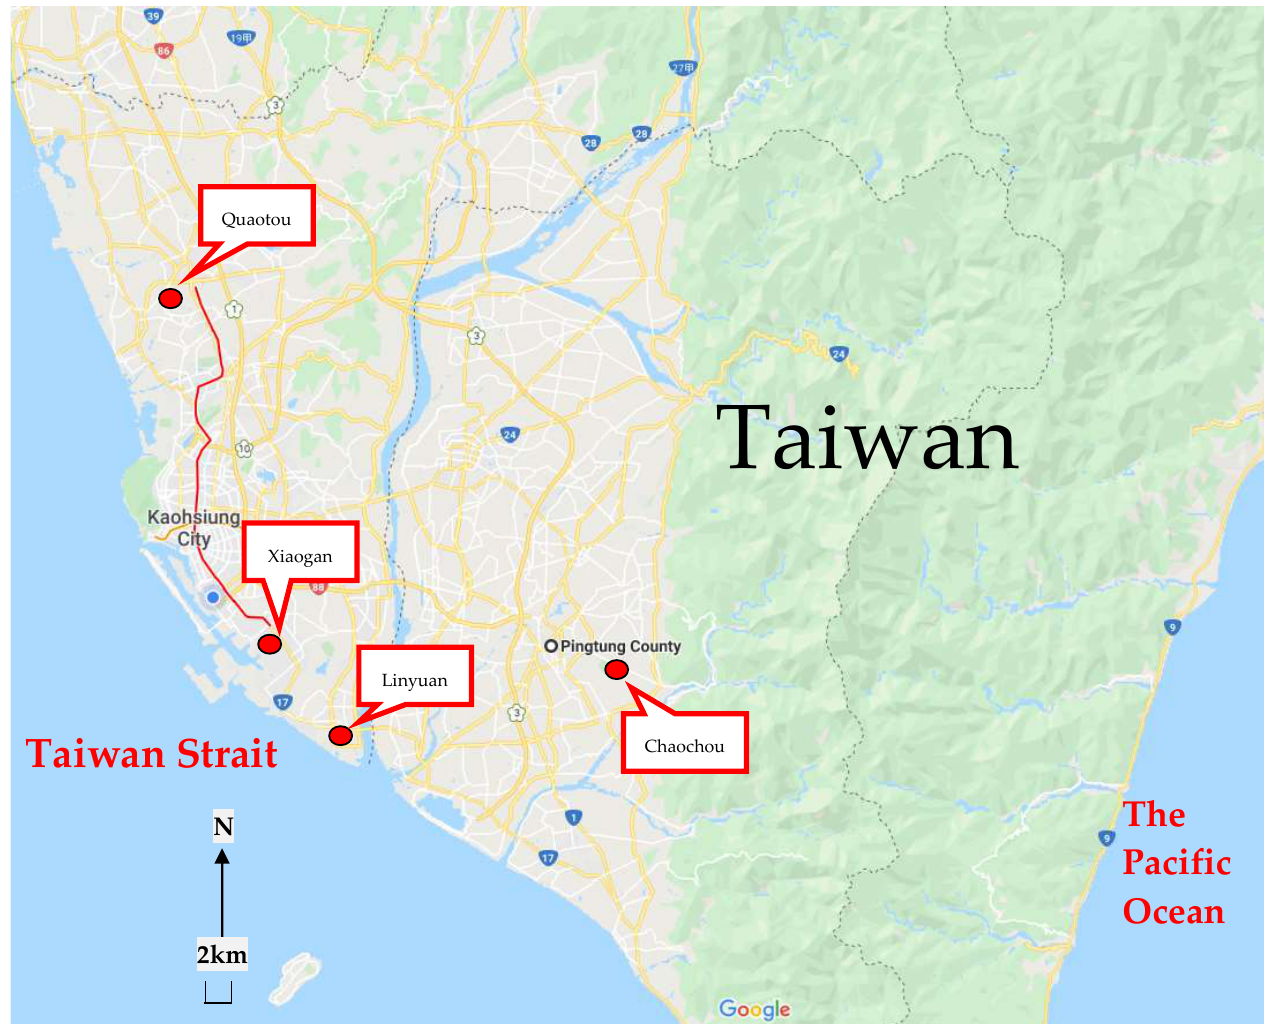
Figure 1. Photochemical monitoring stations in the Kaohsiung-Pingtung area of Taiwan.